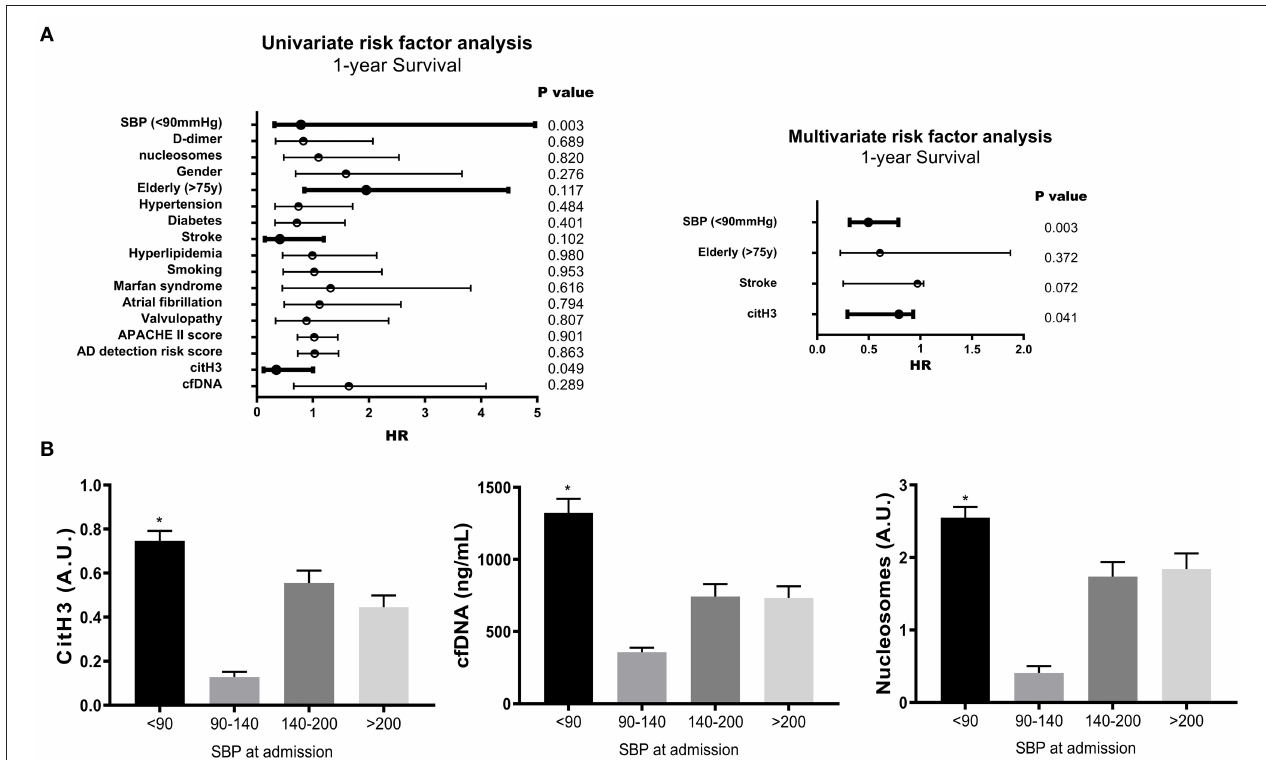
FIGURE 4 | Risk factor analysis of 1-year survival in AAD patients. (A) By univariate and multivariate risk factor analysis, systolic blood pressure (SBP) < 90 mmHg and citH3 levels were identified as independent risk factors for 1-year survival. (B) AAD patients with SBP < 90 mmHg had significantly increased circulating NET markers compared with patients with SBP > 90 mmHg. * P <